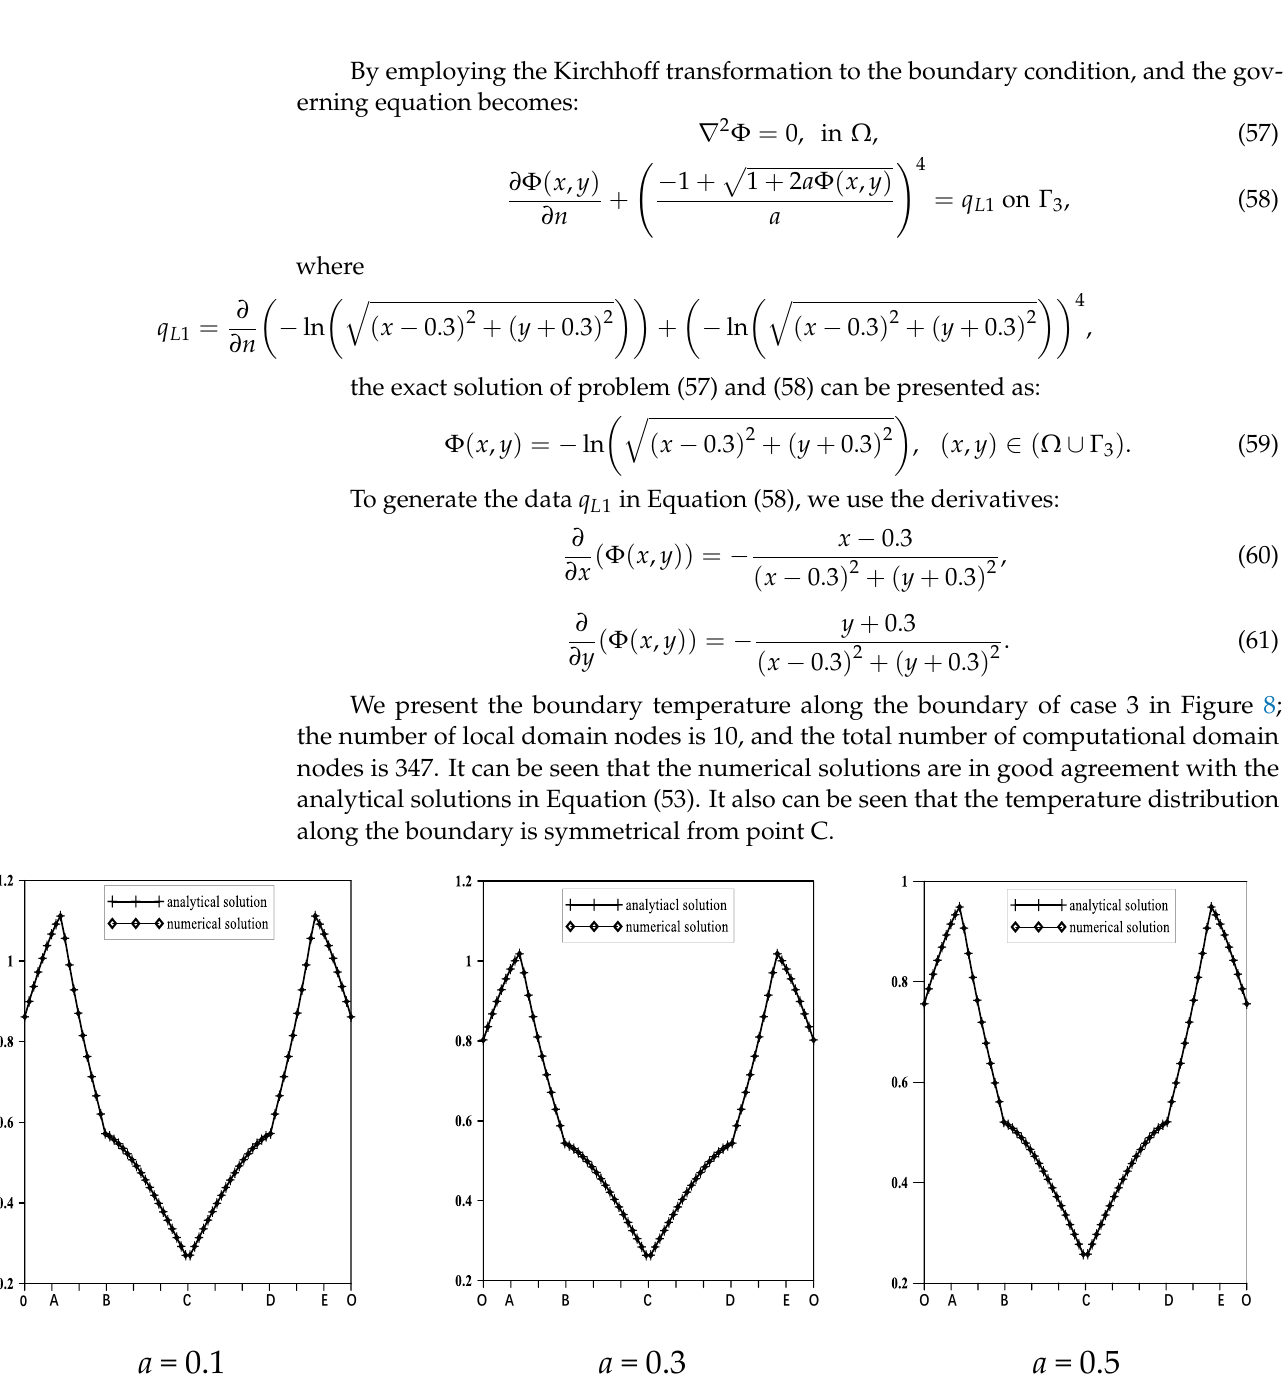
Figure 8. Plot of analytical and the LMFS numerical boundary temperatures along the perimeter, case a = 0.1, 0.3,